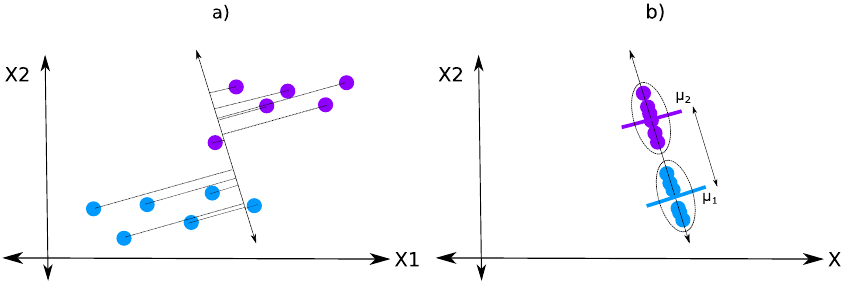
Figure 5. ( a ) The projection of data points on a new “bad” axis. ( b ) The resultant separation with the new axis.